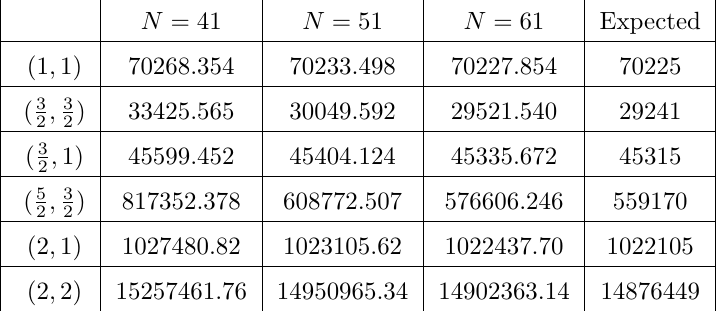
N = 41 N = 51 N = 61 Expected (1 ; 1)